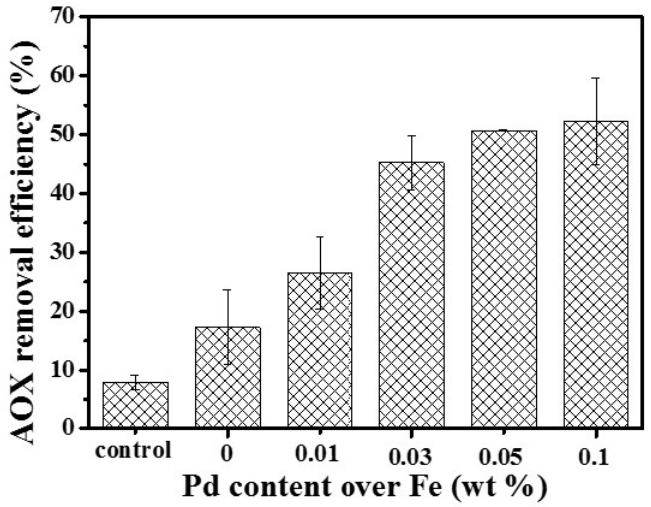
Figure 2. The effect of Pd loading on the removal efficiency of AOX (Fe powder = 10 g/L, Pd/Fe powder = 10 g/L, pH 6.0; reaction time was 15 days).